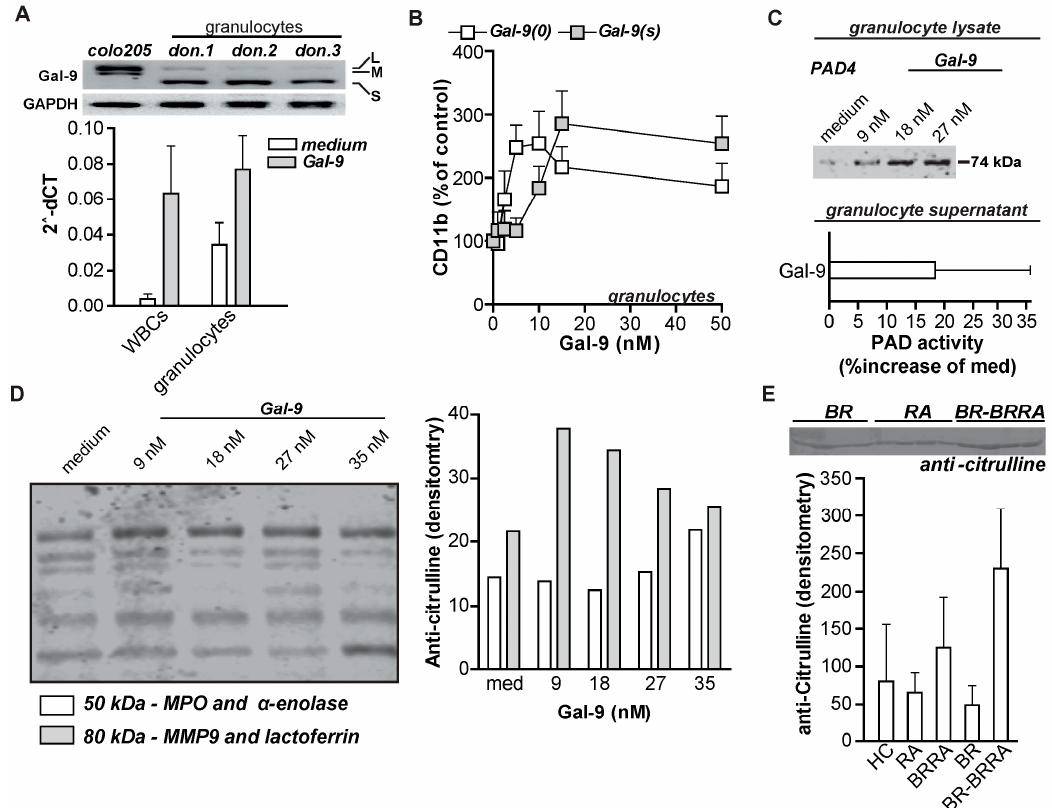
Figure 6. Gal-9 induces potentially autoimmune promoting responses in vitro. ( A ) Upper panel: detection of different Gal-9 isoforms as expressed by granulocytes using conventional PCR and subsequent gel electrophoresis. The colorectal cancer cell line Colo205 was used as a control. Lower panel: RTqPCR expression analysis of Gal-9 mRNA in total WBC or isolated granulocyte populations after treatment with Gal-9 (6 h, 10 nM). ( B ) Expression of CD11b on granulocytes after treatment with Gal-9(0) or Gal-9(s). ( C ) Western blot of protein arginine deiminase 4 (PAD-4) in cell lysates of granulocytes treated for 16 h with different concentrations of Gal-9. Lower panel: PAD-4 activity in supernatants of granulocytes treated with Gal-9 (16 h, 27 nM). ( D ) Detection of citrullination of intracellular proteins in granulocytes treated with Gal-9 (0–35 nM). Identification of citrullinated peptides was determined by LTQ-Orbitrap Velos mass spectrometry. ( E ) Relative differences of citrullination from 1 µL aliquots of serum proteins immunoblotted from HC, BR, BRRA, and BR patients that seroconverted to BRRA within 1 year (termed BR-BRRA). Immunoblots are representative of two or more experiments and bands from replicate gels were analyzed by mass spectrometry. All other experiments were performed at least in triplicate, except for the data in Figure 6A, which was in duplicate.